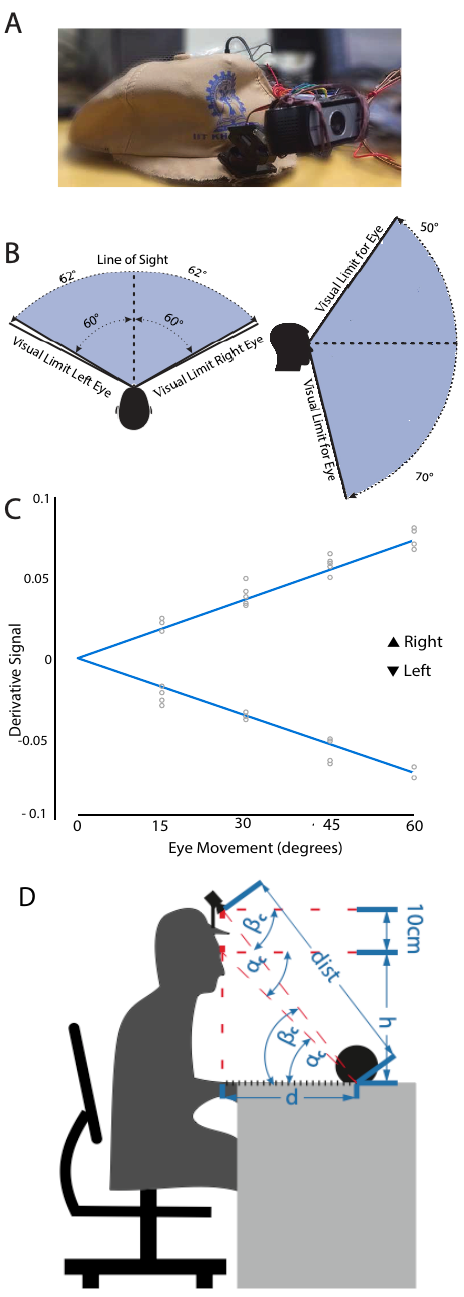
Figure 3. ( A ) The instrumented cap visor; ( B ) The users’ field of vision in the horizontal and vertical planes; ( C ) Interpolated line for estimating gaze angles; ( D ) Camera tilting angle β c estimation for an object placed at distance d , on the tabletop h below the eye